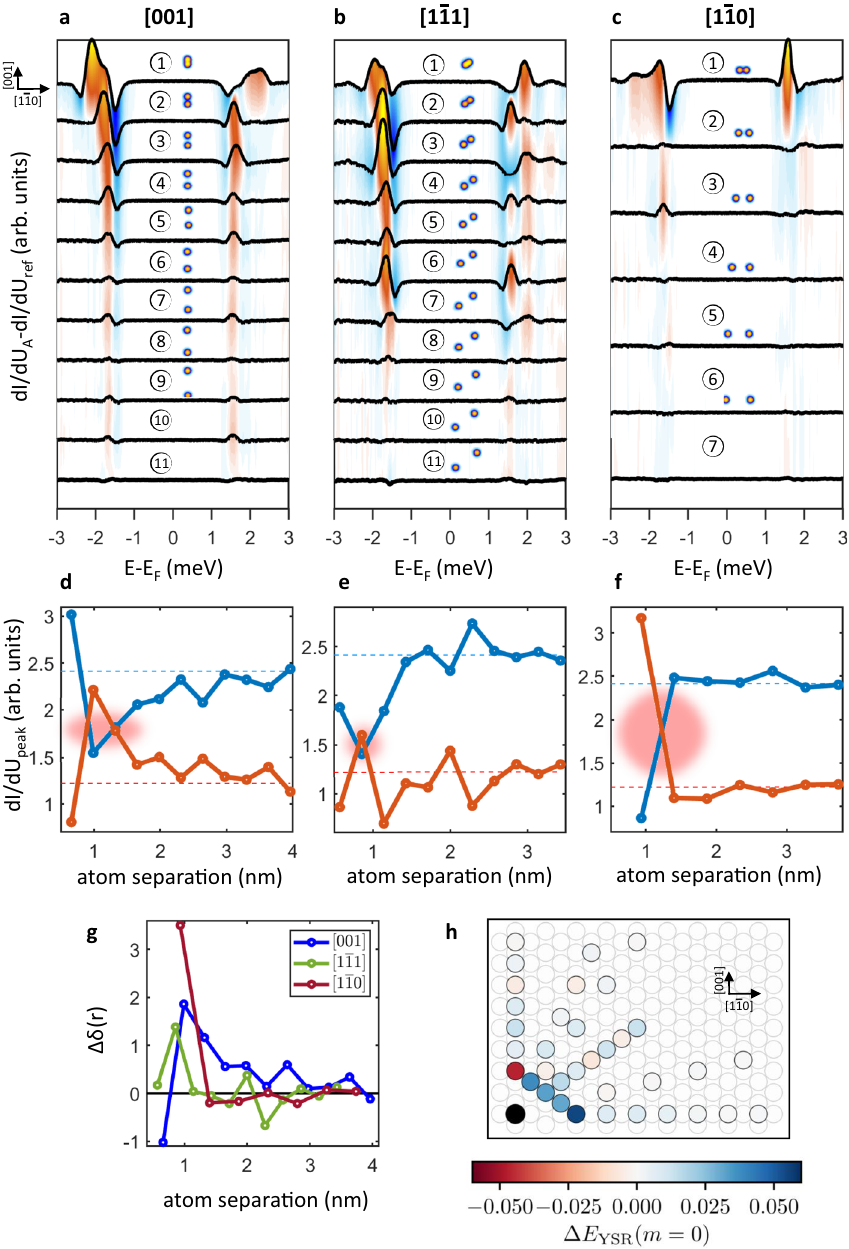
Fig. 3 Distance dependence of the YSR energy spectrum. a – c STS taken on atom A subtracted by the signal on the isolated Cr atom. Spectra are shown for three different directions and several distances, the number in each panel corresponding to the number of discrete steps. d – f In-gap peak maximum for positive (red) and negative (blue) energies as a function of the distance between the adatoms. The dashed lines show the isolated atom intensities. Red shaded areas highlight the occurrence of a quantum phase transition from a free-spin to a screened-spin regime. g Comparison of spectral weight redistribution δ along distinct directions and at different distances. Zero corresponds to the isolated adatom case. h First-principles calculations of the shift of the YSR energies of the z 2 -derived orbital with respect to the single adatom YSR energies. The black dot illustrates the fi xed atom A, while the colored positions represent atom B and therefore the formed dimer con fi guration. Adsorption site positions on the Nb lattice correspond to the cases measured experimentally. The color code indicates the calculated shift in YSR energy for the respective Cr